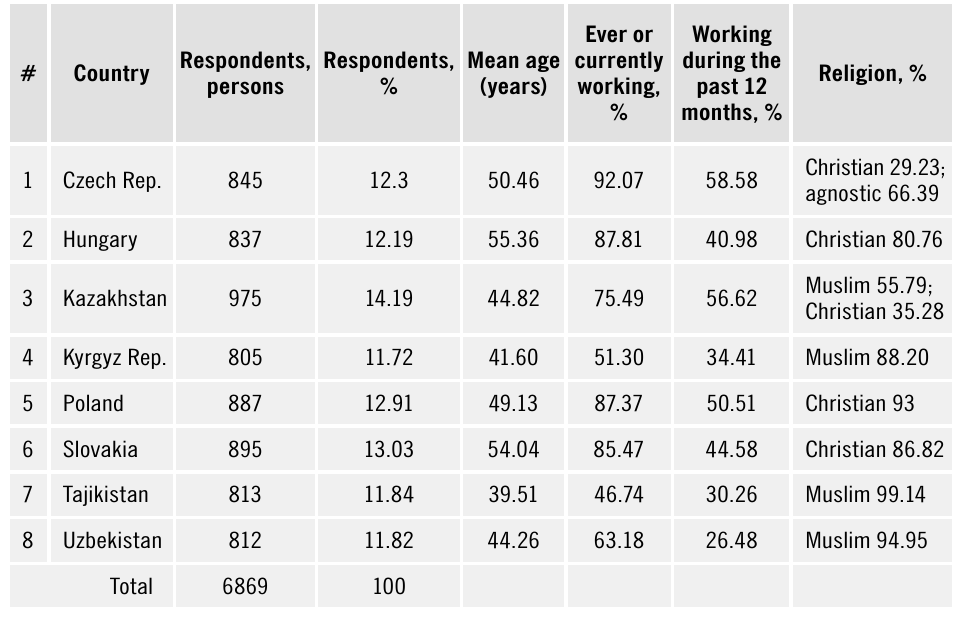
Table 1. Characteristics of the sample by